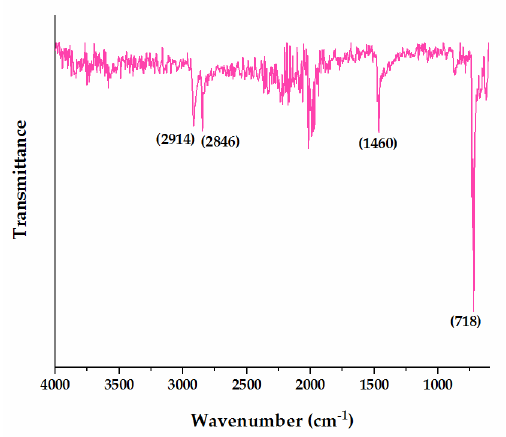
Figure 6. ATR-FTIR spectrum of fragments derived from low-density polyethylene (LDPE) plastic bag.